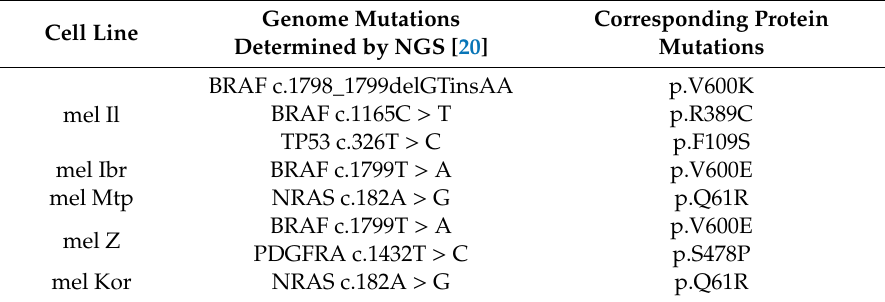
Table 1. Mutations in melanoma cell lines